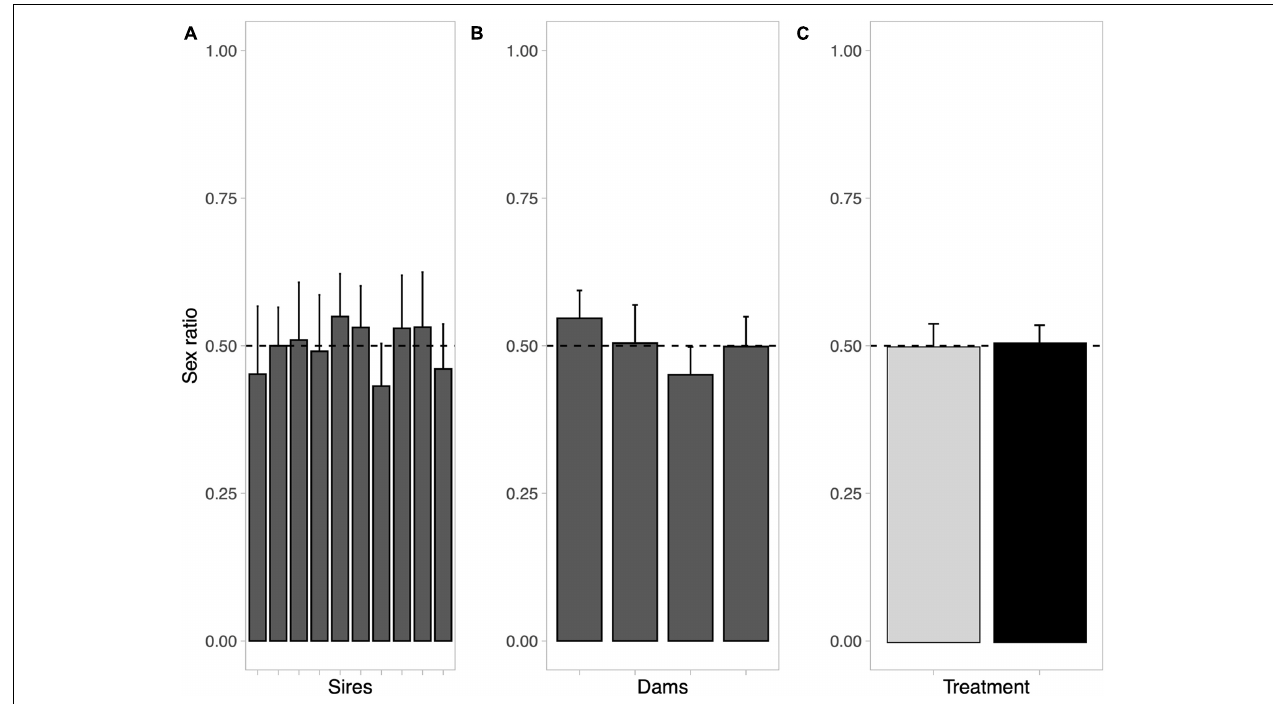
FIGURE 1 | Average sex ratios of (A) all paternal sib groups, (B) all maternal sib groups, and (C) of embryos fertilized with water only (gray bar) or with diluted ovarian fluid (black bar). Bars indicate means per full-sib family and treatment, with 95% confidence intervals. Sex ratio range from all females (0) to all males (1). The horizontal dashed lines indicate even sex